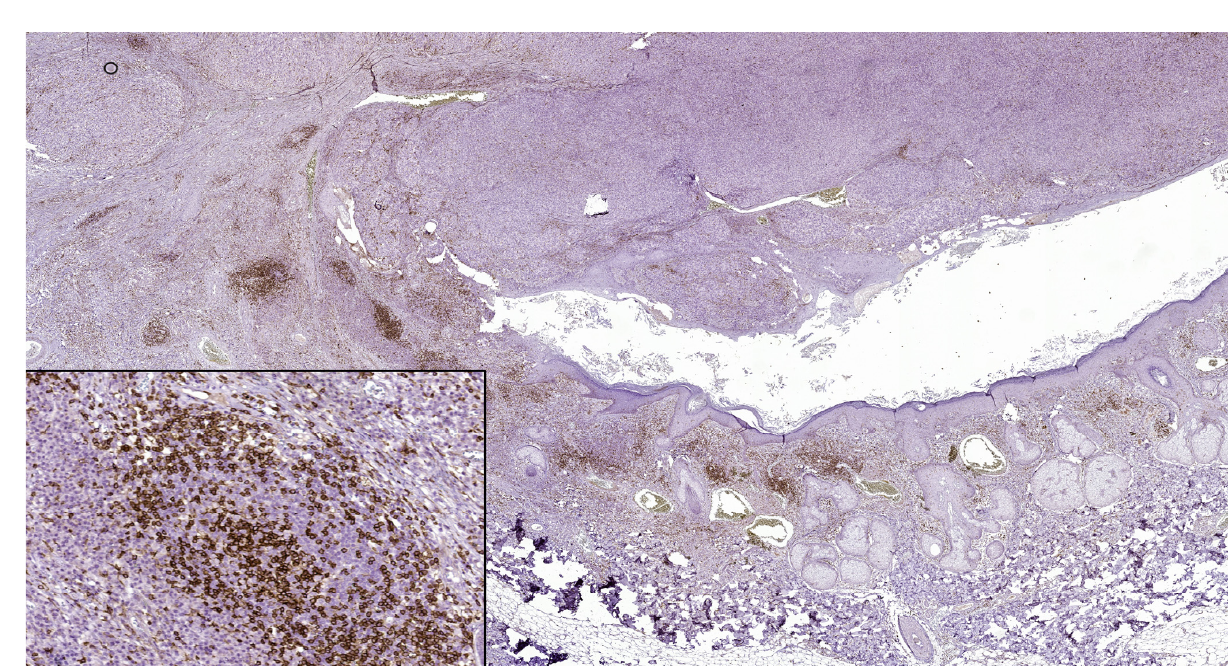
Figure 1. In nodular polypoid melanoma, CD4 intense membranous expression in intra and peritumoral lymphocytes (CD4 monoclonal antibody, clone EP204). In the lower left side detail, obx200.